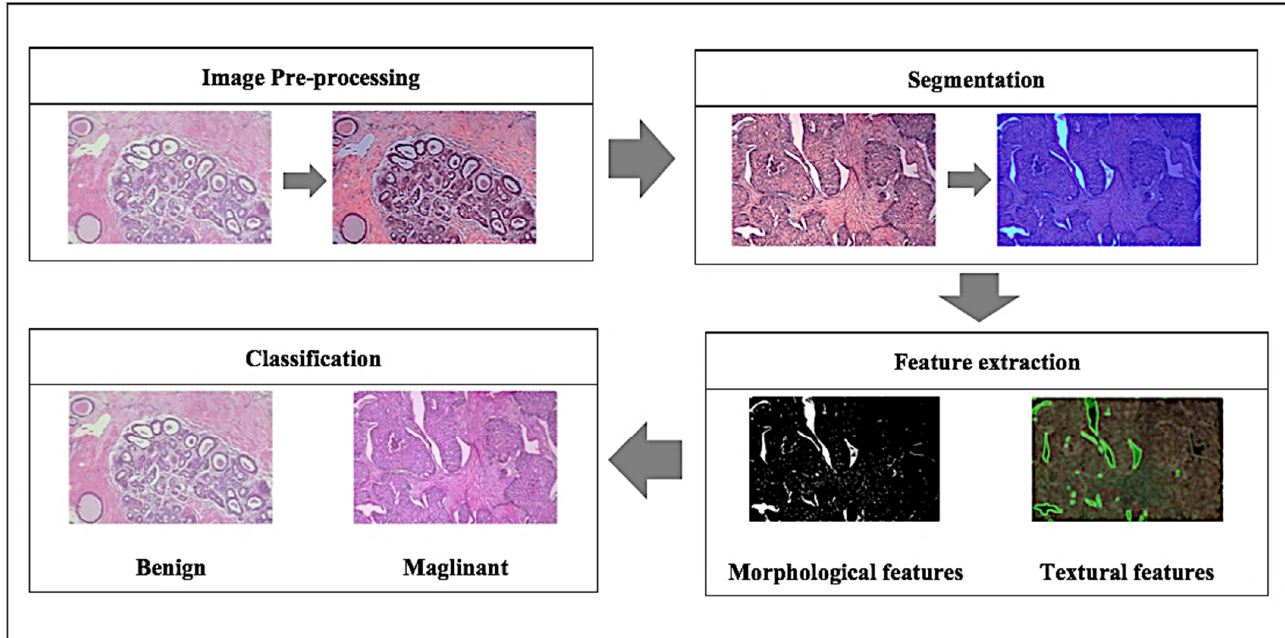
Figure 2. Core steps involved in a breast cancer computer-aided diagnosis system.